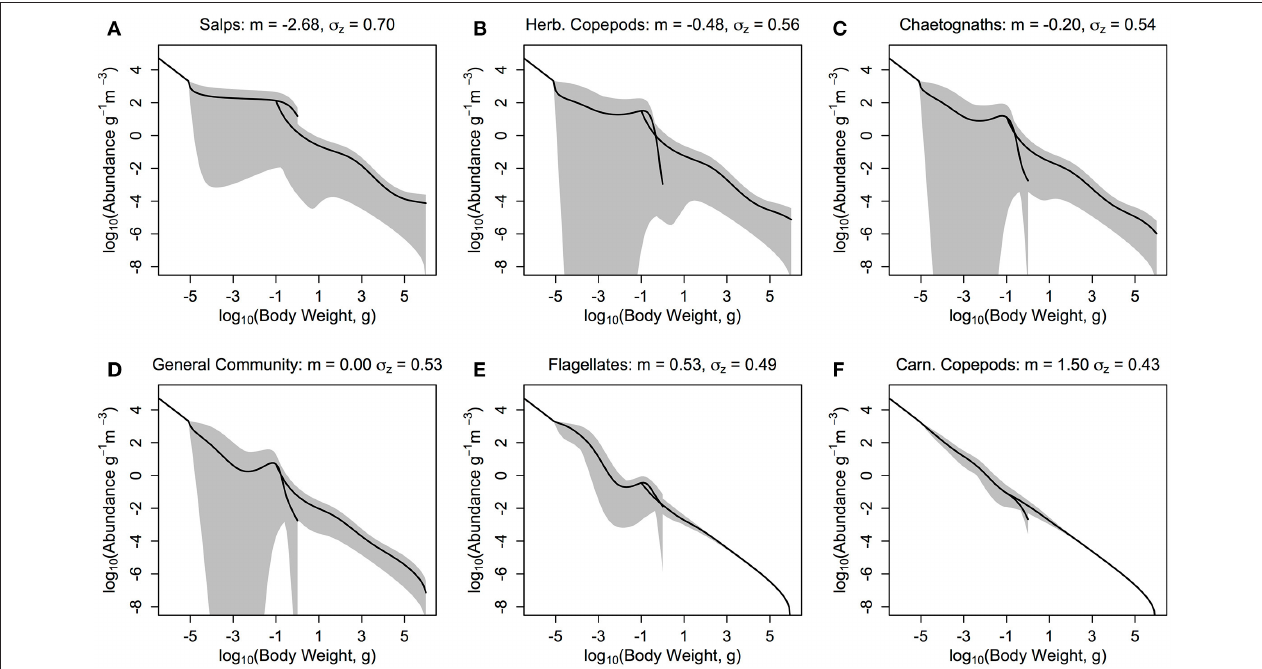
FIGURE 6 | The zooplankton and fish community size-spectra when the zooplankton community is defined by the feeding characteristics (here, quantitative feeding mode m ; Wirtz, 2012, and feeding kernel width σ z ; Fuchs and Franks, 2010) of a single functional group. (A) Salps ( m 0.70), (B) Herbivorous Copepods ( m 0.48, σ z 0.56), (C) Chaetognaths ( m 0.20, σ z 0.54), (D) General Community ( m = − = = − = ( m 0.53, σ z 0.49), and (F) Carnivorous Copepods ( m 1.50, σ z 0.43). The solid lines denotes the average abundance slope of the zooplankton and fish = = = = communities over 10 years. The shaded areas show the regions of the travelling wave solutions over 10 years if the steady state is unstable.